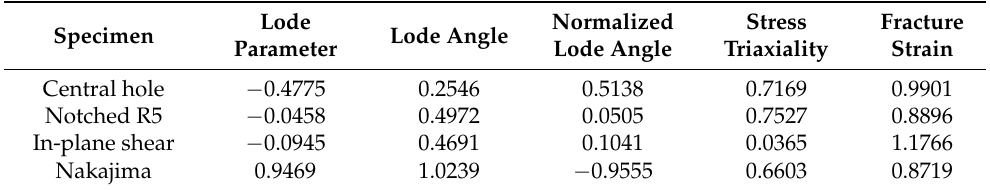
Table 7. Fracture stain, the Lode parameter, and the stress triaxiality obtained by hybrid numerical– experimental approach for bainite specimens.